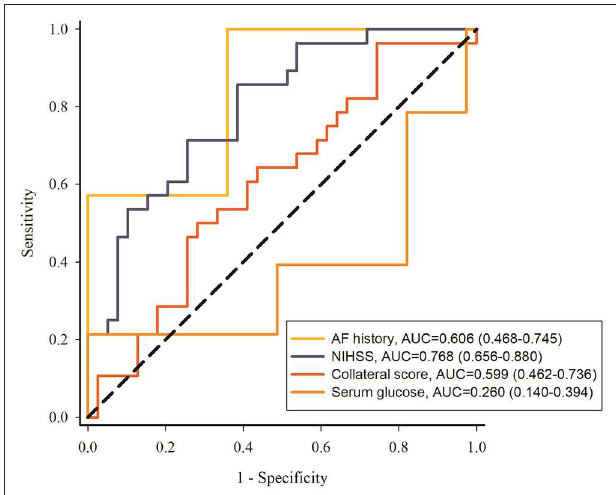
FIGURE 4 | ROC curves of atrial fibrillation history, NIHSS, collateral score and serum glucose to predict the HT. NIHSS, National Institute of Health Stroke Scale; AF, atrial